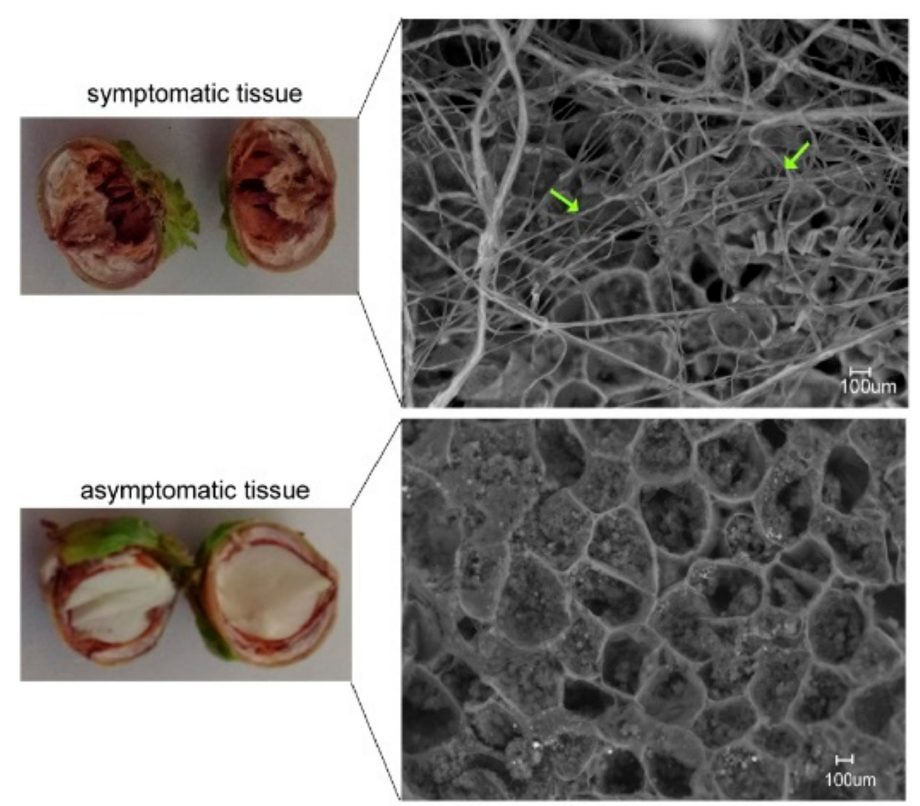
Figure 2. Scanning electron micrographs of BCNc ( above ) and BCNc ( below ) nuts.